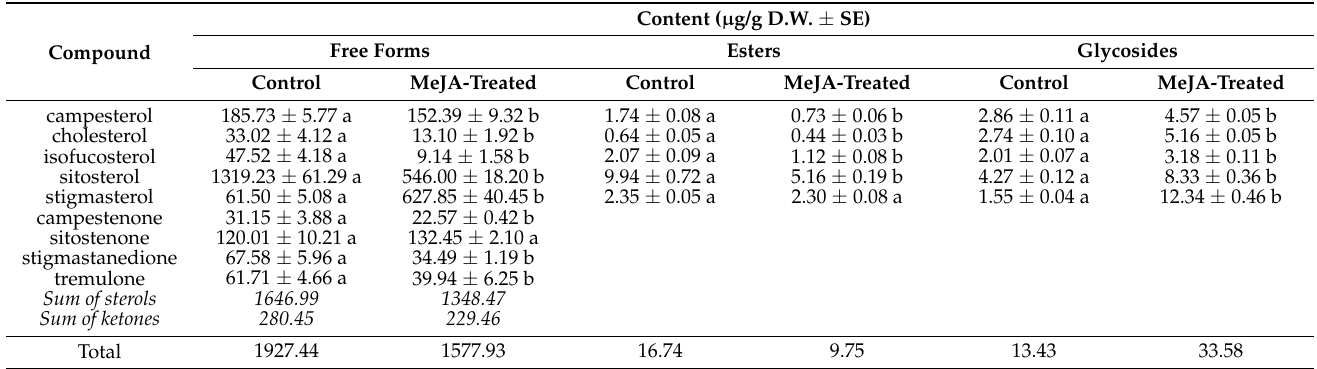
Table 1. The content of steroids in the T. × media KT hairy root line after elicitation with 100 µ M MeJA.